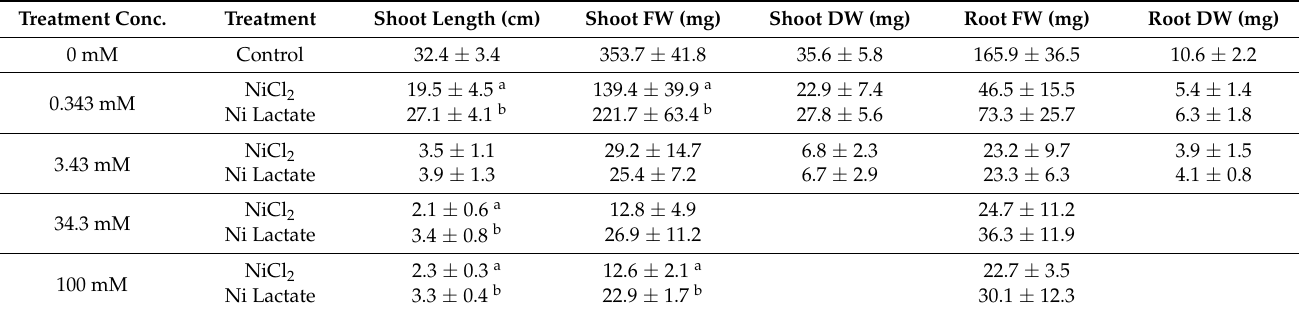
Table 7. Plant growth parameter results for nickel (Ni) treatments. After 13 days of growth, wheat seedlings were harvested, and shoot length was measured along with fresh weight (FW) and dry weight (DW) of both root and shoot tissue. A t -test was used to identify differences between nickel chloride and nickel lactate treatments within each treatment level for each plant growth parameter, where superscripts “a” and “b” denote treatment differences of p < 0.05. ± : standard deviation. Treatment Conc.